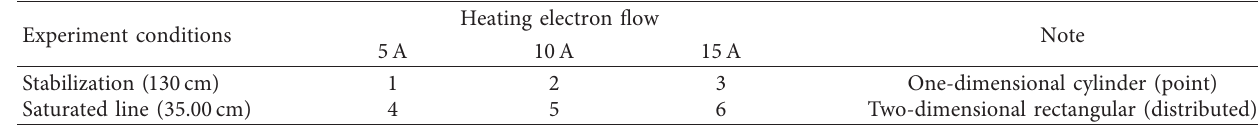
Table 1: Experimental